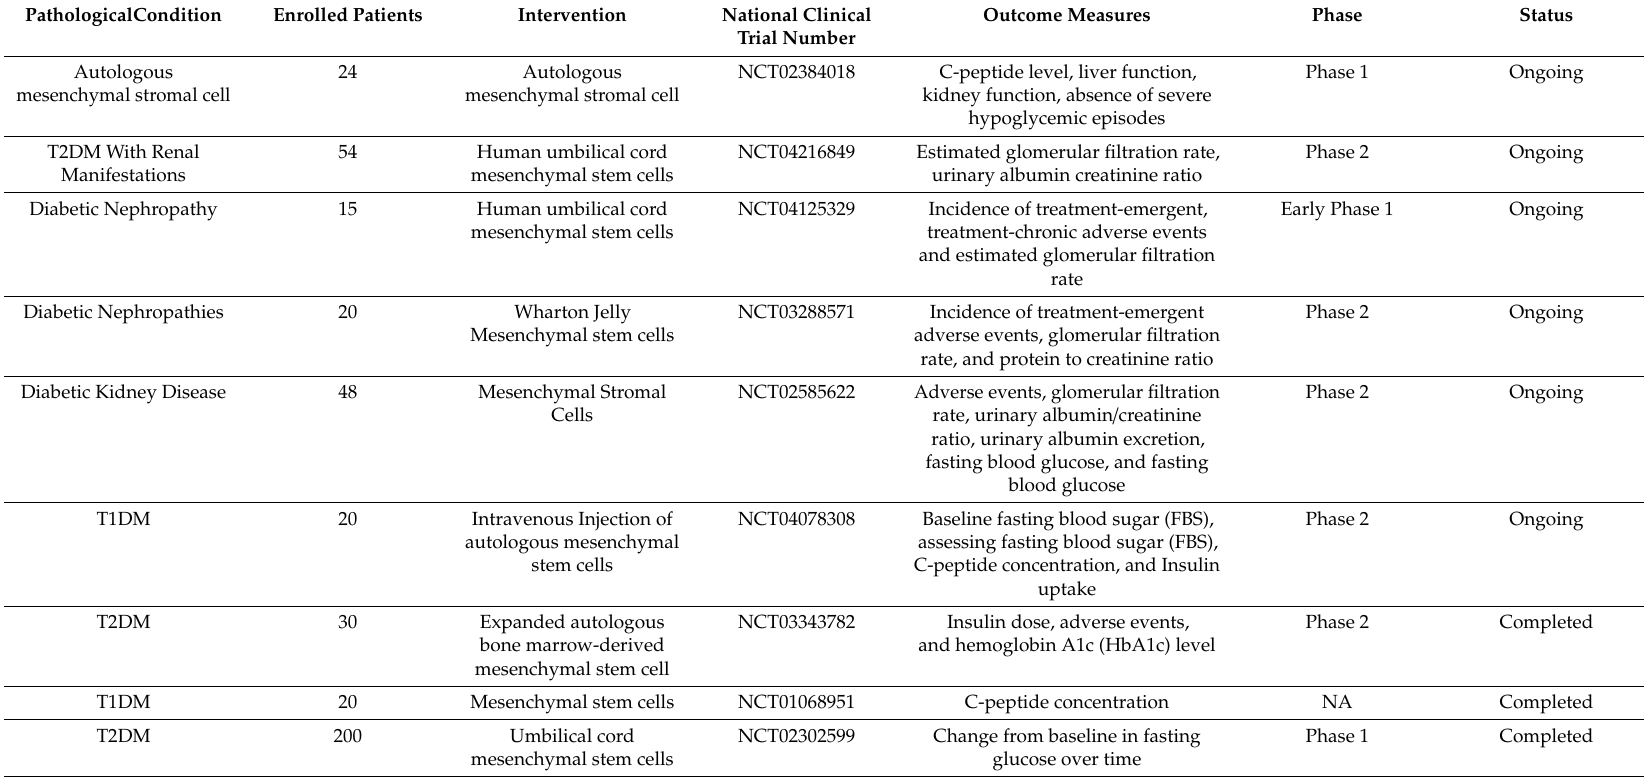
Table 4. Description about the list of clinical trials taken from https: // www.clinicaltrials.gov /